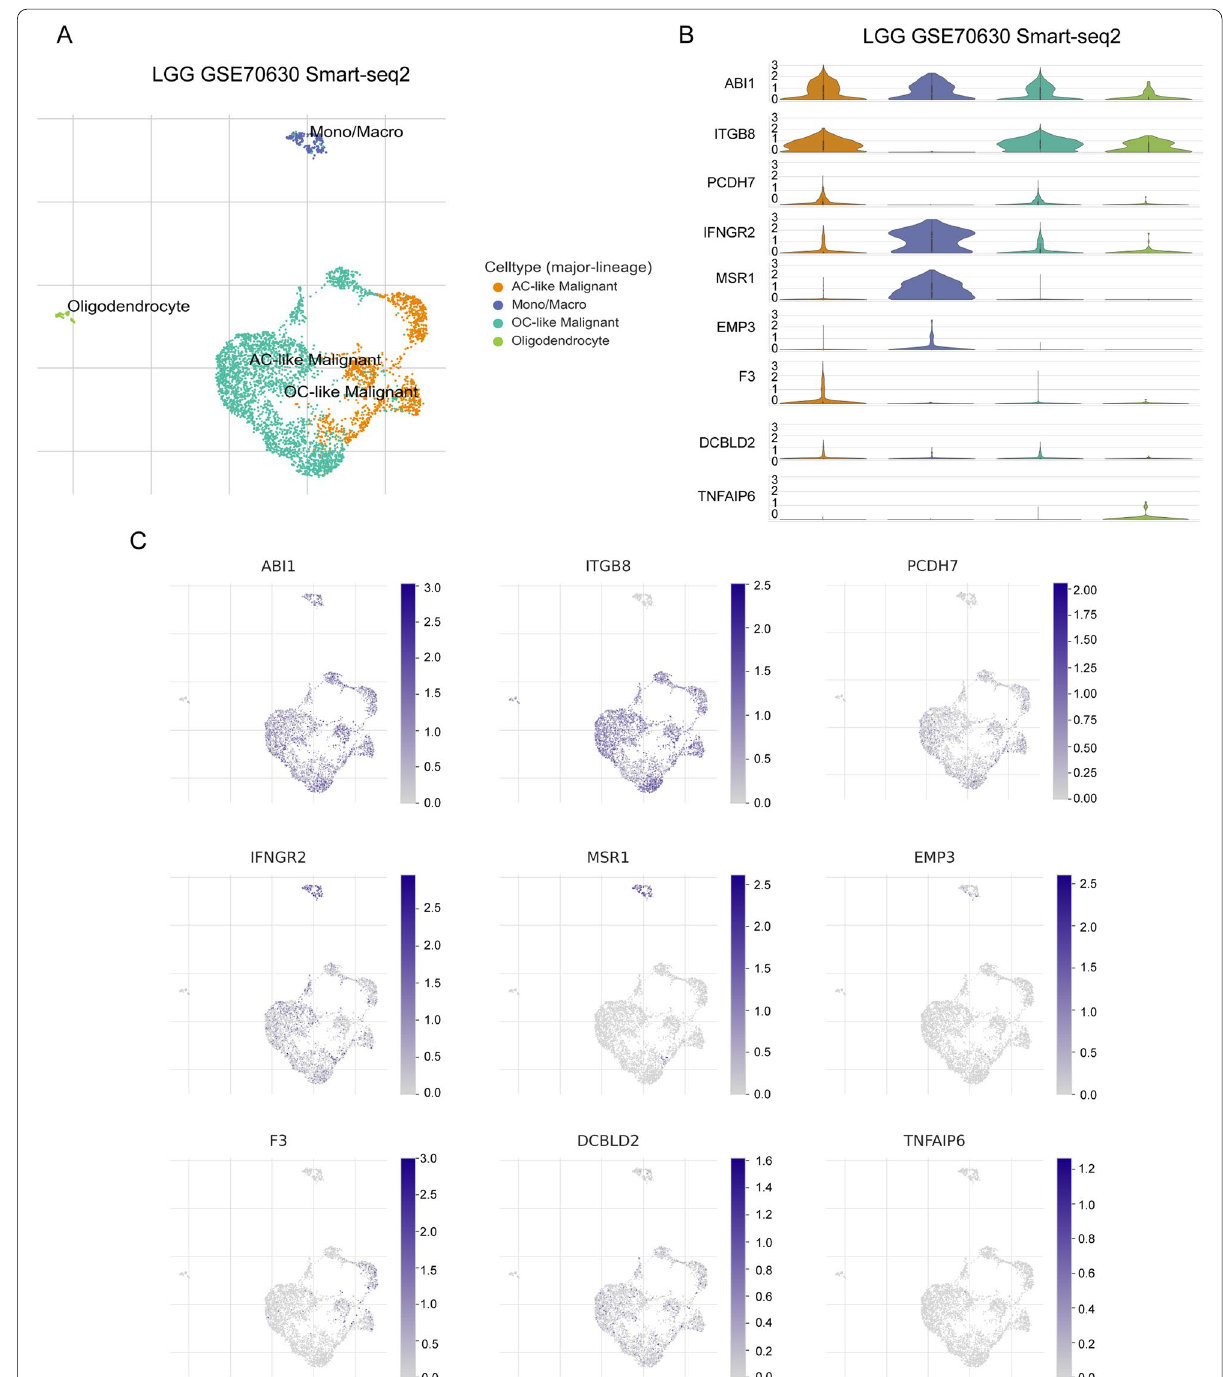
Fig. 8 scRNA-Seq reveals inflammation genes expression patterns. A UMAP plots showing major cell subsets identified by 10 Violin plots ( B ) and UMPA ( C ) plots showing different expression patterns of inflammatory response